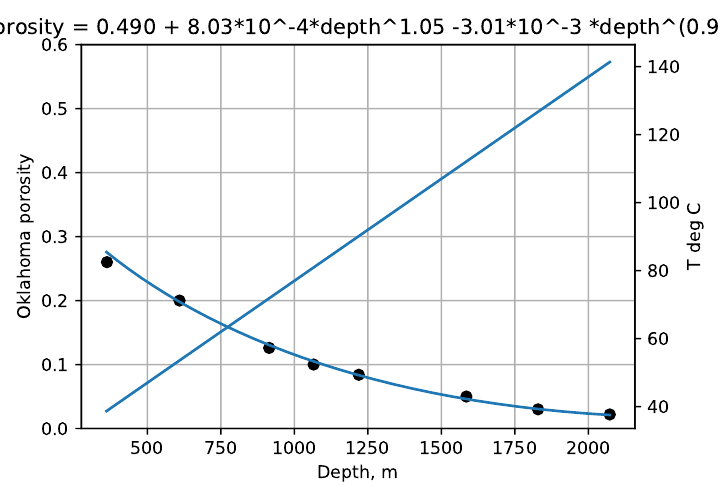
Figure 4. Sulu porosity trend.